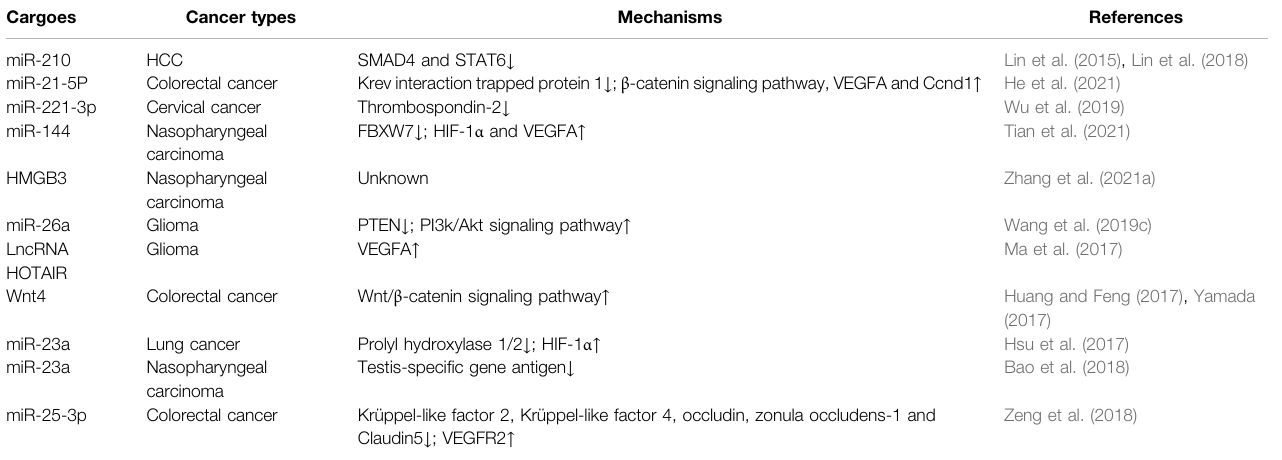
TABLE 1 | Role of tumor-derived EVs in